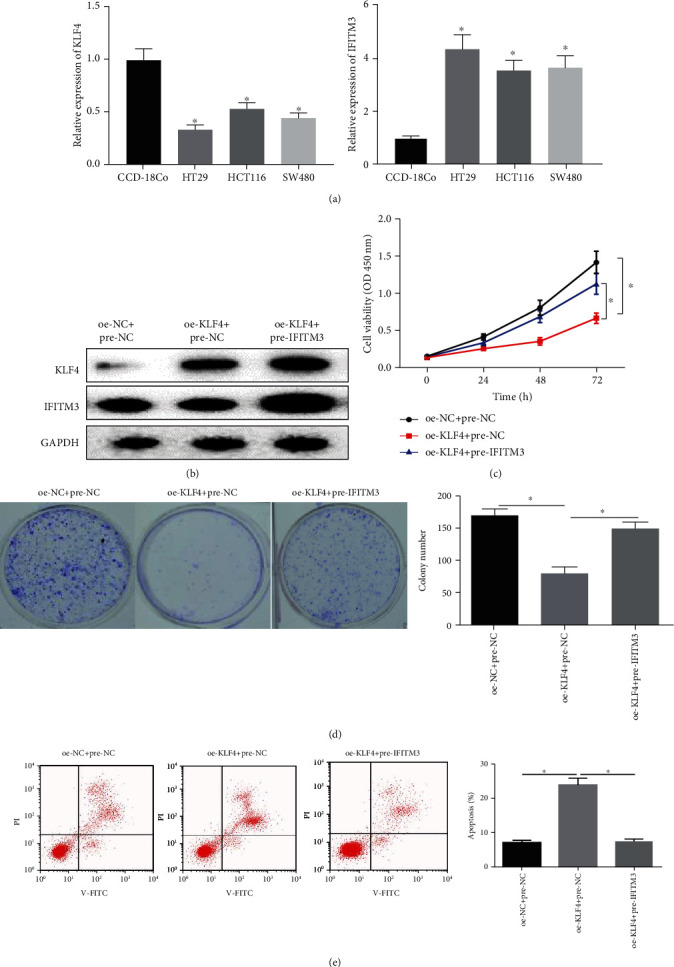
The overexpression of KLF4 mediates the IFITM3 expression to regulate colon cancer cell proliferation and apoptosis. (a) The expression of KLF4 and IFITM3 in the normal cell line CCD-18Co and colon cell lines HT29, HCT116, and SW480 was detected by qRT-PCR. (b) Western blot was carried out for the protein examination of KLF4 and IFITM3 in cells transfected with oe-NC+pre-NC, oe-KLF4+pre-NC, and oe-KLF4+pre-IFITM3. (c) CCK-8, (d) colony formation assay, and (e) flow cytometry were performed to determine cell viability, colony-forming ability, and cell apoptosis (∗ means p < 0.05).